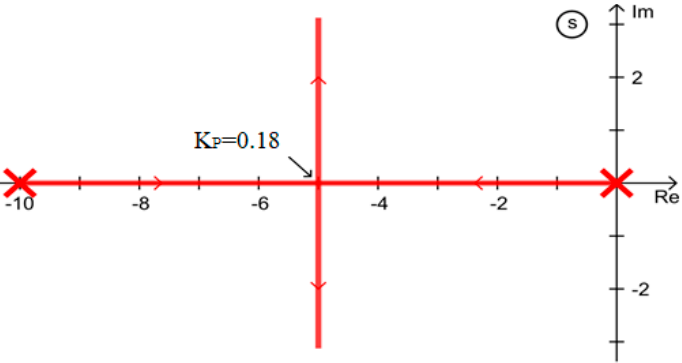
Figure 5. Root locus of the speed controller without smoothing in the feedback.